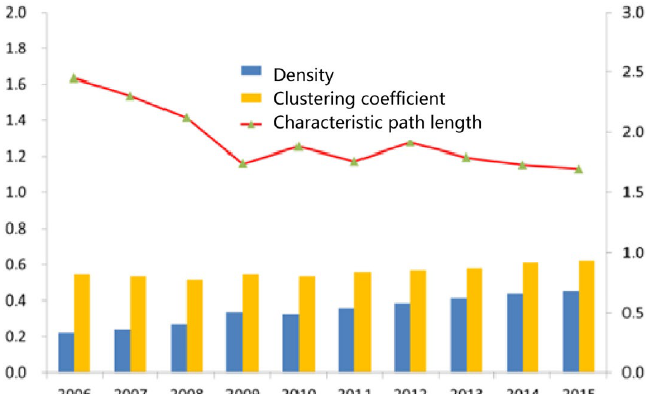
Figure 3. The overall characteristic index of the Pearl River Delta traffic correlation network (2006–2015). Notes : See 31 for the path measurement method of the density, clustering coefficient and path length of the network.